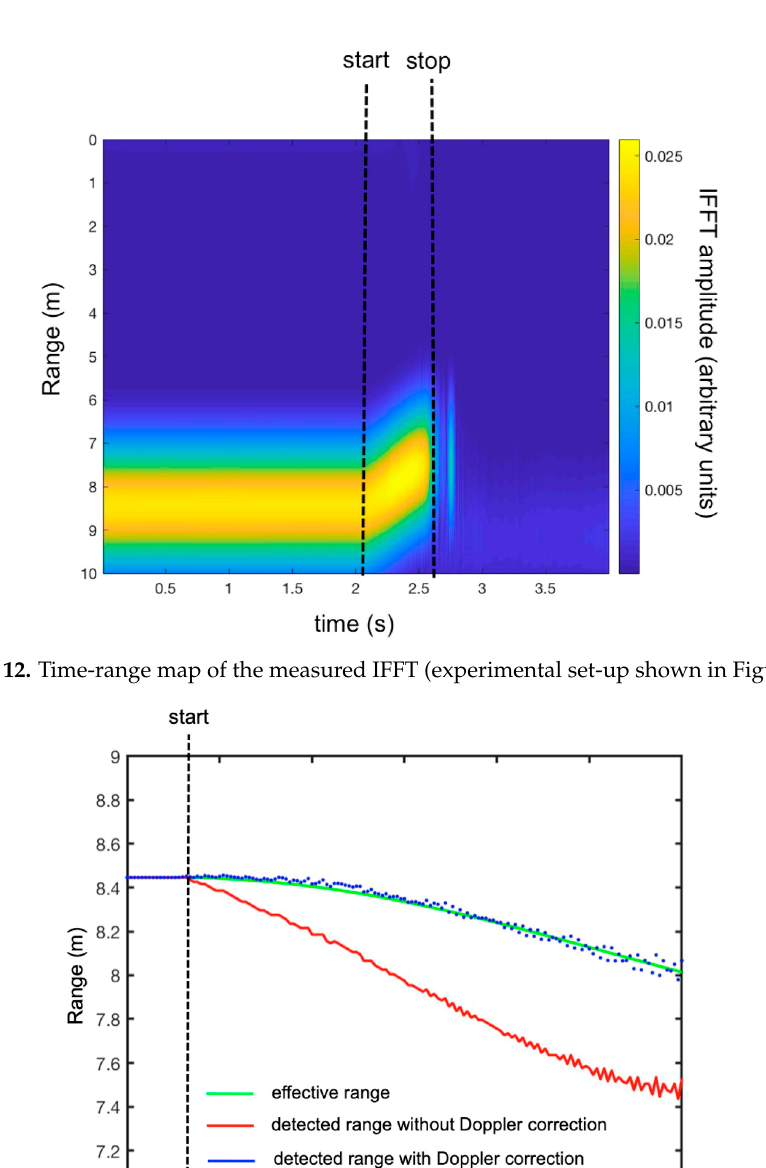
Figure 13. Measured plots of the peaks’ range in time (experimental set-up shown in Figure 8). The green line is the theoretical range of the target, the red line is the range of the peaks without the Doppler correction, and the blue dotted line is the range of the peaks with the Doppler correction.